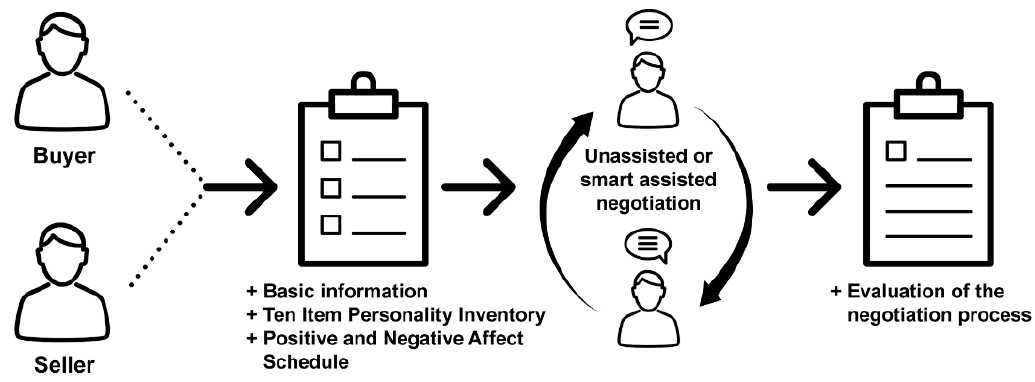
Figure 1. The case study process with twenty embedded units.